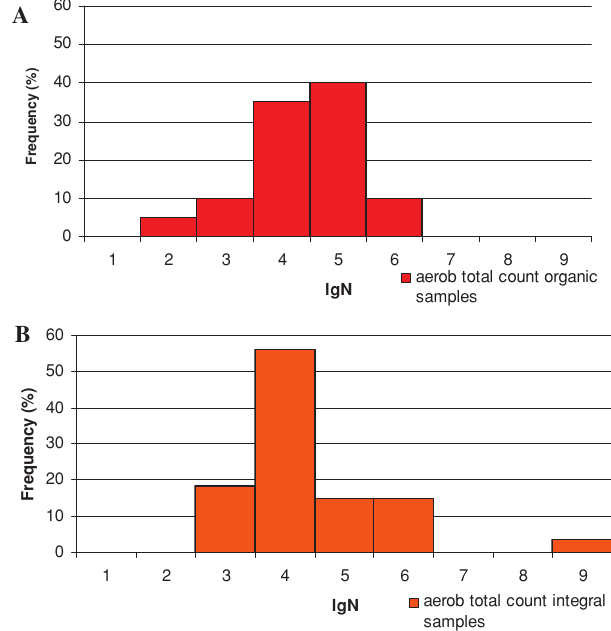
Figure 1. Frequency distribution of the surface aerobic total count contamination of apple from organic (A) and integrated (B) production